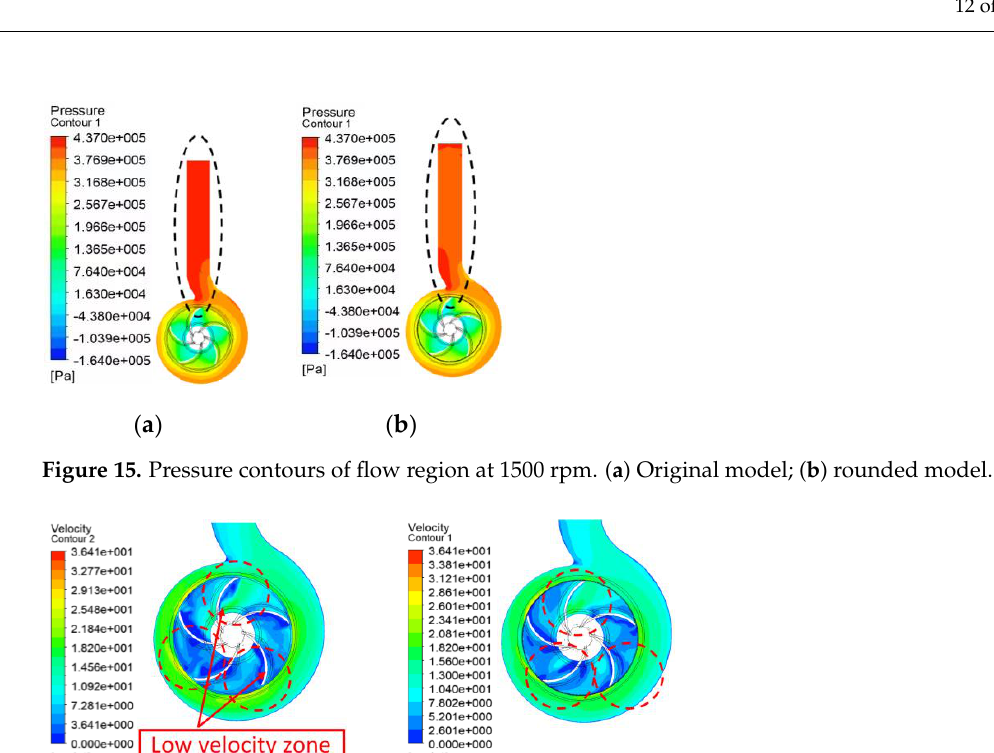
( b ) Figure 13. Velocity contours of flow region at 1250 rpm. ( a ) Original model; ( b ) rounded model. ( a ) ( b ) Figure 14. Velocity vector of flow region at 1250 rpm. ( a ) Original model; ( b ) rounded model. Similar to the pressure distribution at 1250 rpm, when the rated speed is 1500 rpm, the flow obstruction at the inlet of the impeller is also reduced after modification. As